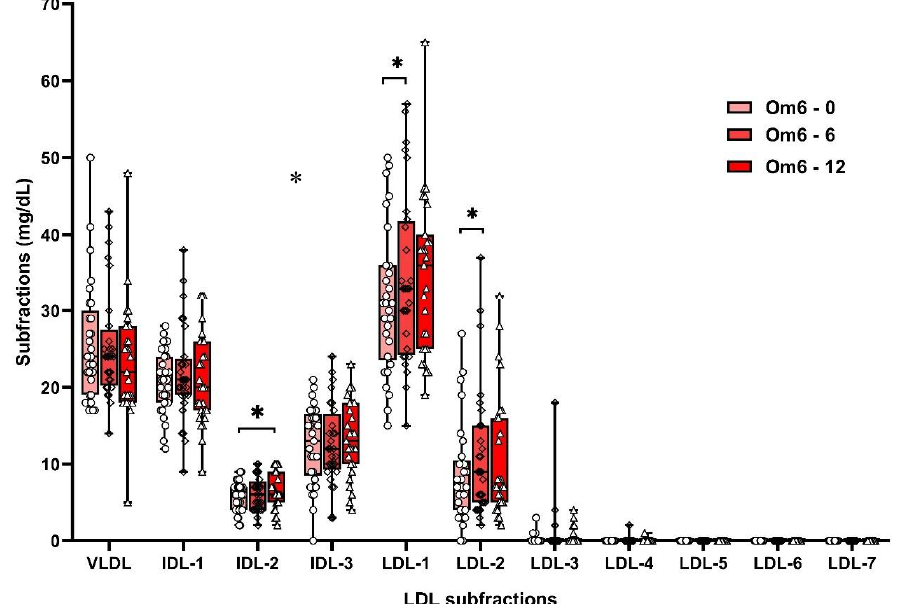
Figure 3. LDL subfractions in Om6 group at the baseline and after 6 and 12 weeks of supplementation. VLDL—very low-density lipoproteins, IDL—intermediate density lipoproteins, LDL—low-density lipoproteins, Om6—omega-6 group, * p <